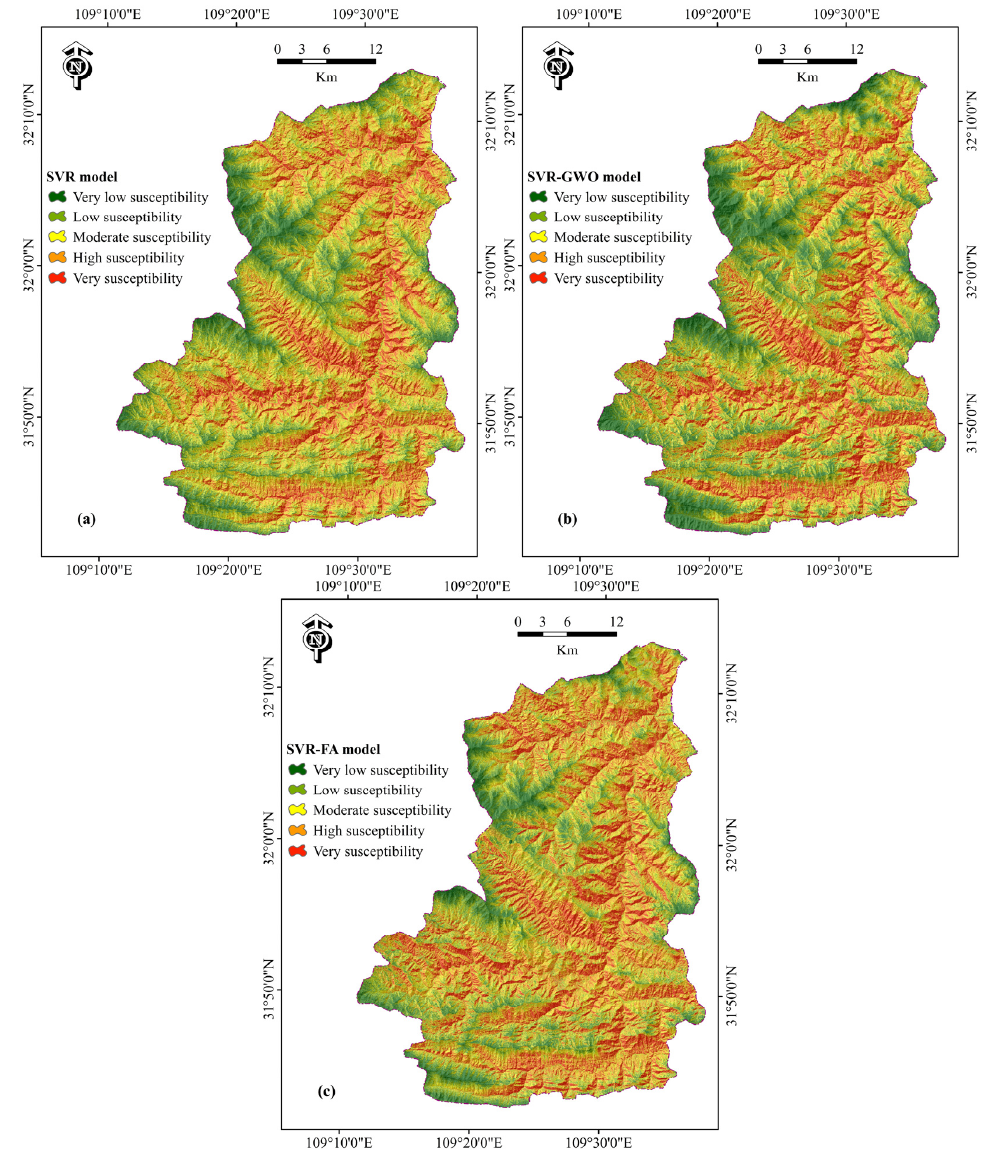
Figure 12. Landslide susceptibility maps: ( a ) SVR model, ( b ) SVR-GWO model, ( c ) SVR-FA model.